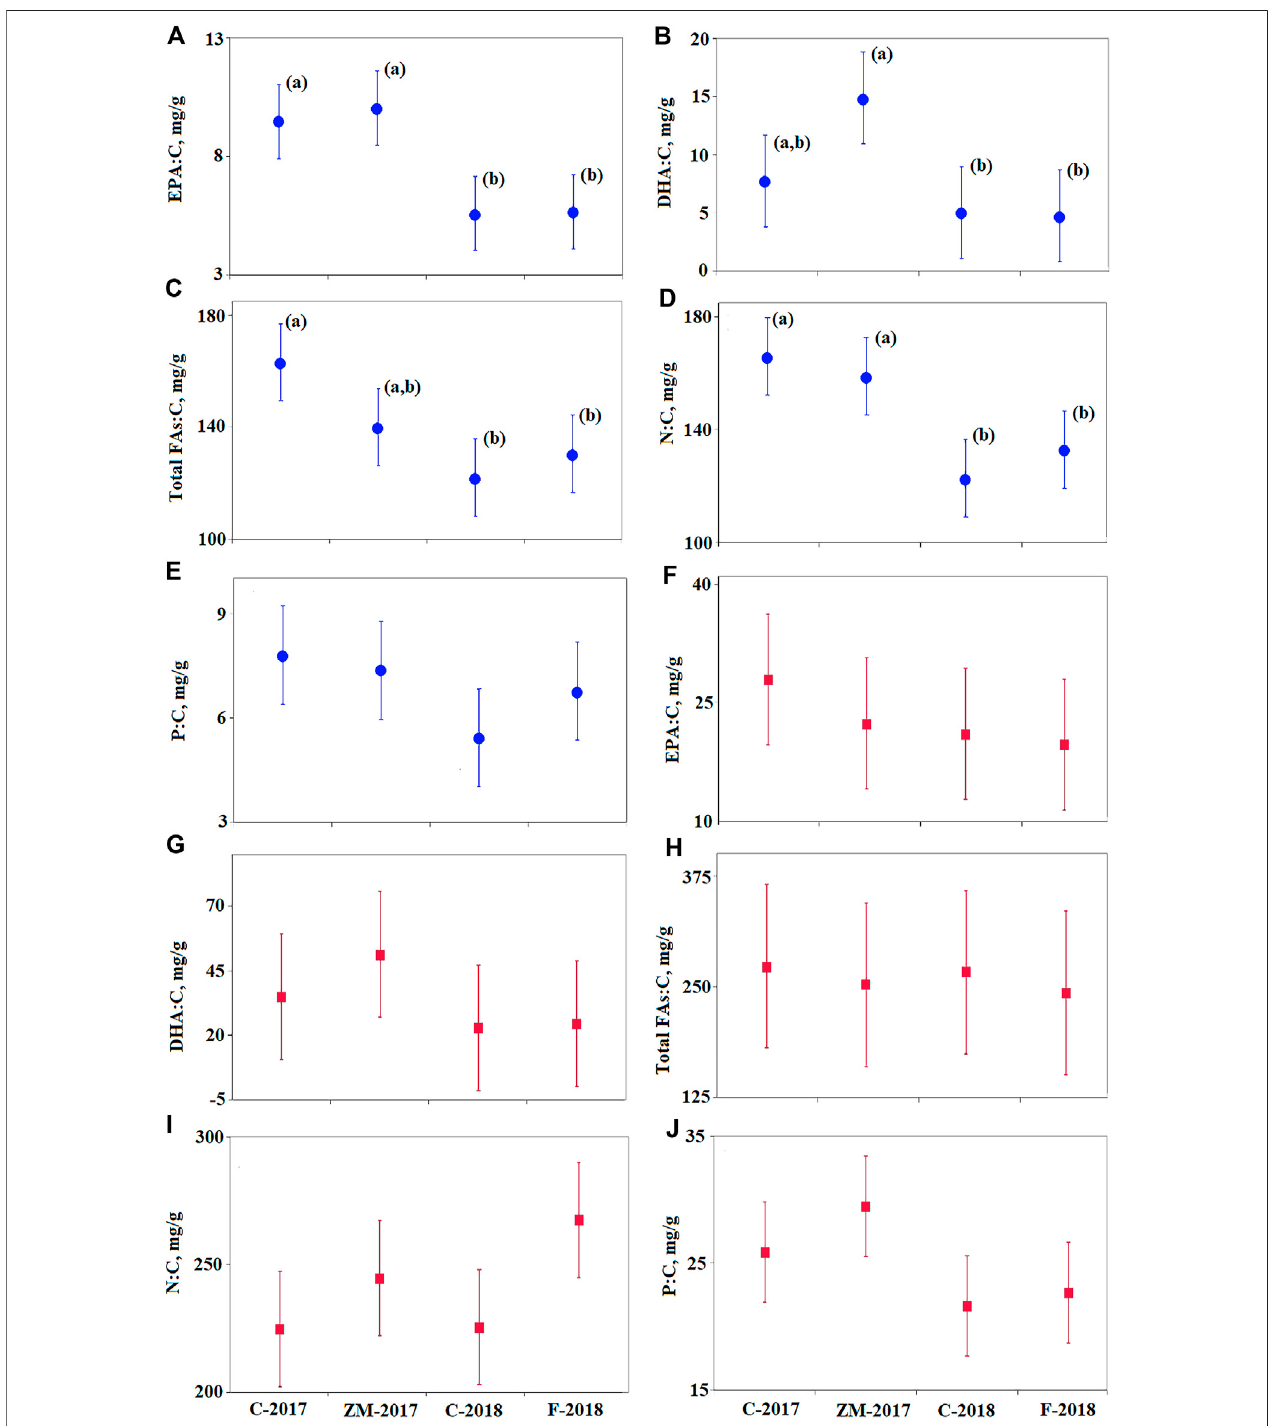
FIGURE2| Comparison ofthecontentsofessential elements and fatty acidsin phytoplanktonand zooplankton between treatments(C-2017,ZM-2017, C-2018, and F-2018) on day 1 in the 2017 and 2018 experiments. Signi fi cant differences were determined using Fisher ’ s LSD post hoc test ( p < 0.05). Vertical bars represent 95% Fisher ’ s LSD intervals. See Table 1 for statistical parameters obtained by two-way GLM ANOVA. Signi fi cant differences between the treatments are depicted with different letters. (A – E) Plots for phytoplankton (blue circles); (F – J) plots for zooplankton (red squares).